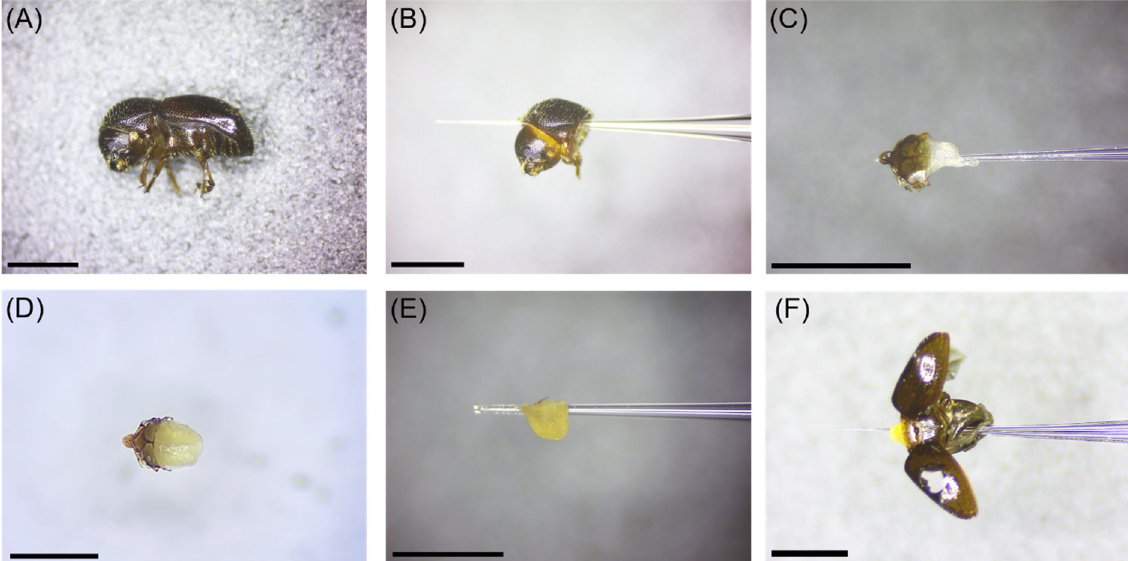
Figure 1. Selected tissue types dissected from laboratory-reared (LR) and field-collected (FC) specimens of Xylosandrus germanus consisting of ( A ) whole body of LR and FC female specimens, ( B ) head + pronotum of LR and FC specimens, ( C ) deflated mycangium + scutellum from LR specimens only, ( D ) inflated mycangium + scutellum of LR and FC specimens, ( E ) inflated mycangium from LR and FC specimens, and ( F ) inflated mycangium + scutellum + thorax (excluding the pronotum) + abdomen from LR and FC specimens. Scale bar in each figure represents 1.0 mm.